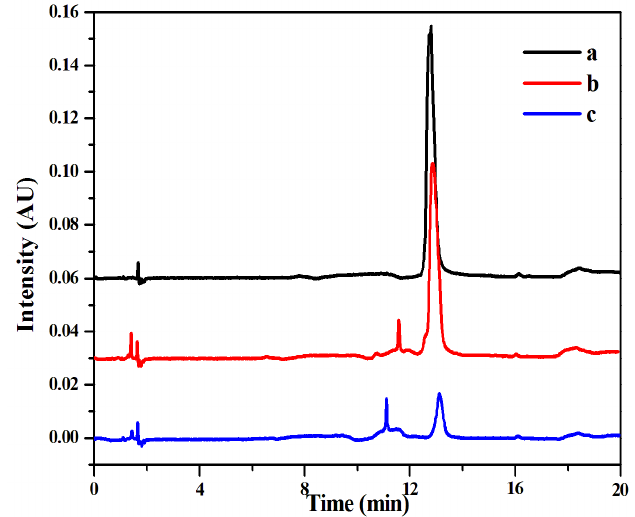
Figure 11. High performance liquid chromatography of the three solutions: MTX standard solution ((a) 0.05 mg mL − 1 ), the spiked solution extracted by MMIPs ((b) 0.05 mg mL − 1 ) and the spiked solu- tion extracted by MNIPs ((c) 0.05 mg mL − 1 ).